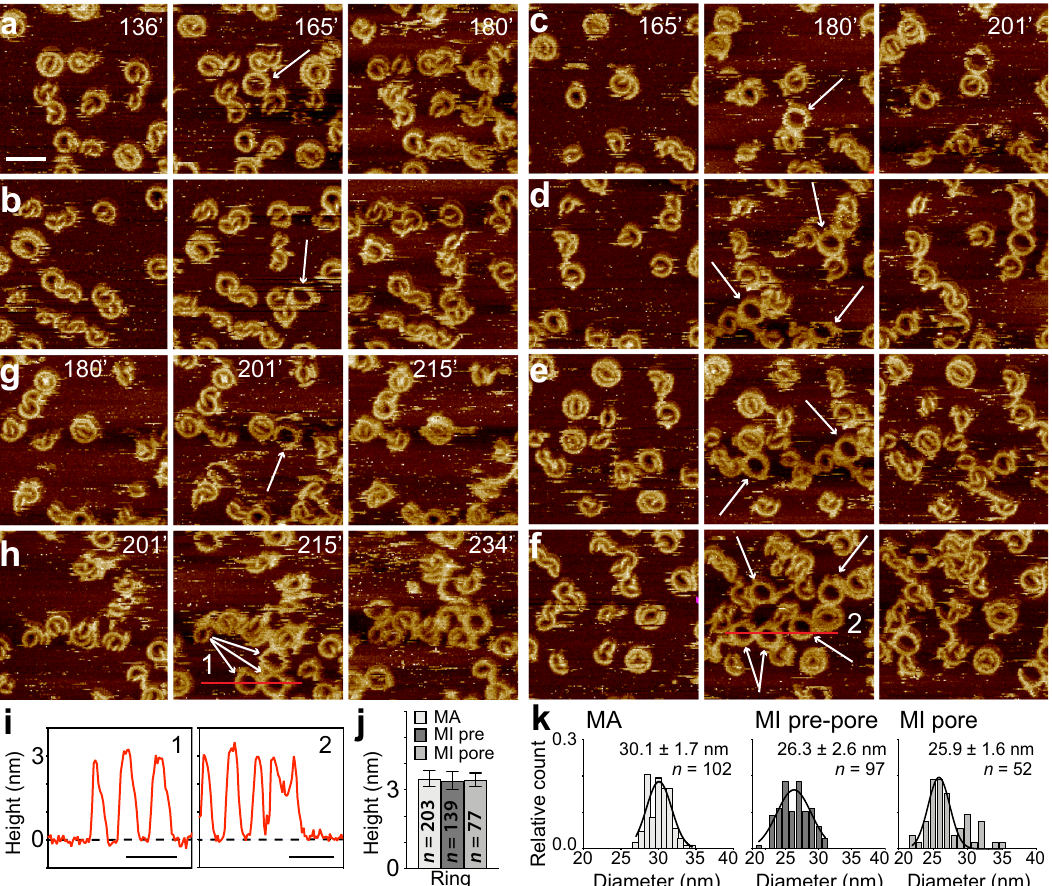
Fig. 2 Time-lapse AFM sequences showing mobile membrane-attached and immobile membrane-inserted mGSDMA3 Nterm oligomers. a – h A defect- free SLM made from E. coli polar lipid extract was incubated with imaging buffer solution containing 1.5 µ M mGSDMA3, which had been beforehand cleaved with 0.4 µ M TEV overnight at 37 °C, and imaged in the same solution at 37 °C. Recorded at different time points of the incubation (time stamps indicate minutes), the time-lapse AFM topographs monitor the assembly, disassembly and diffusion of mGSDMA3 Nterm oligomers. From a to h , the topographs follow over the time course different areas of the SLM. The central topographs capture mobile ring-shaped mGSDMA3 Nterm oligomers (indicated by white arrows) which were not there previously (topograph on the left side) and which thereafter disassemble or change position (topograph on the right side). The time-lapse FD-based AFM topographs were recorded in imaging buffer solution at 37 °C ( “ Methods ” ), and their full-range color scale corresponds to a vertical scale of 6 nm. Scale bar of 50 nm applies to all topographs. i , Height pro fi les of mobile mGSDMA3 Nterm oligomers measured along the red lines indicated in the AFM topographs ( f , h ). Numbers in the upper right corner correlate height pro fi les to red lines in topographs. Black dashed lines represent the membrane surface (0 nm height). j Maximum heights of ring-shaped oligomers residing in the membrane-attached (MA) and membrane-inserted pre-pore (MI pre) and pore (MI pore) state. Values present mean ± SD and are given in Supplementary Table 1. k Diameters of the maximum height of ring-shaped mGSDMA3 Nterm oligomers residing in the membrane-attached (MA) and membrane-inserted pre-pore (MI pre-pore) and pore (MI pore) state and imaged by time-lapse AFM. Black curves represent Gaussian fi ts determining the mean ± SD values given. n gives the number of oligomers analyzed. For further information on the representative time-lapse AFM series see Supplementary Fig. 3 and Movie (Fig. 2i). The mobile oligomers and the immobile oligomers residing in the pre-pore and pore state protruded by the same height above the membrane (Fig. 2j, Supplementary Table 1).